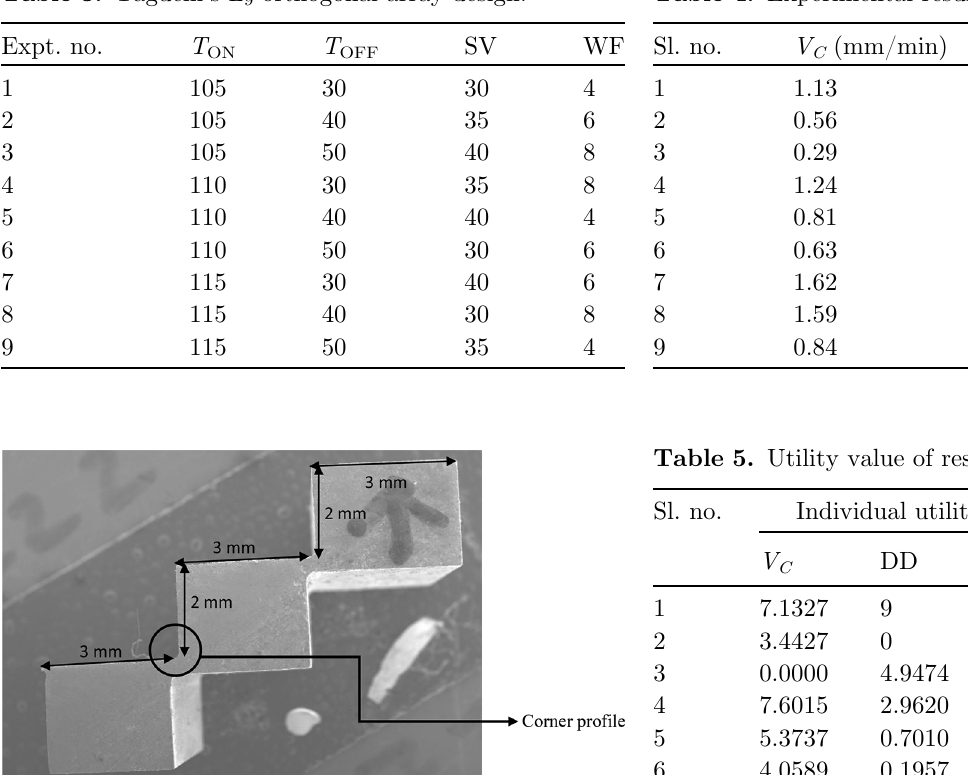
Table 4. Experimental results.